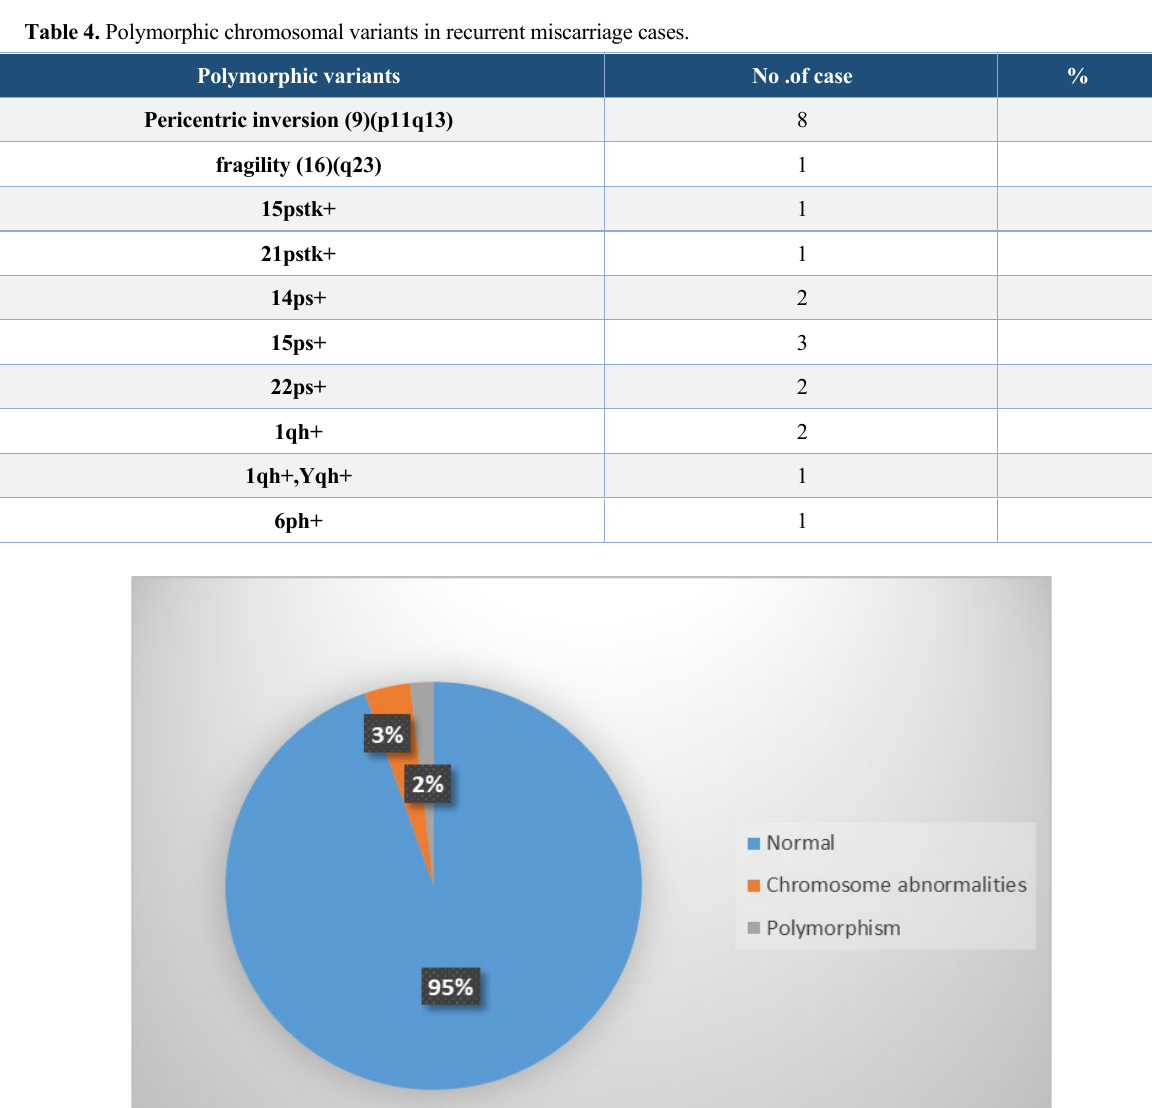
Fig 1. Pie chart for the percentage of abnormal karyotypes and polymorphisms observed in this